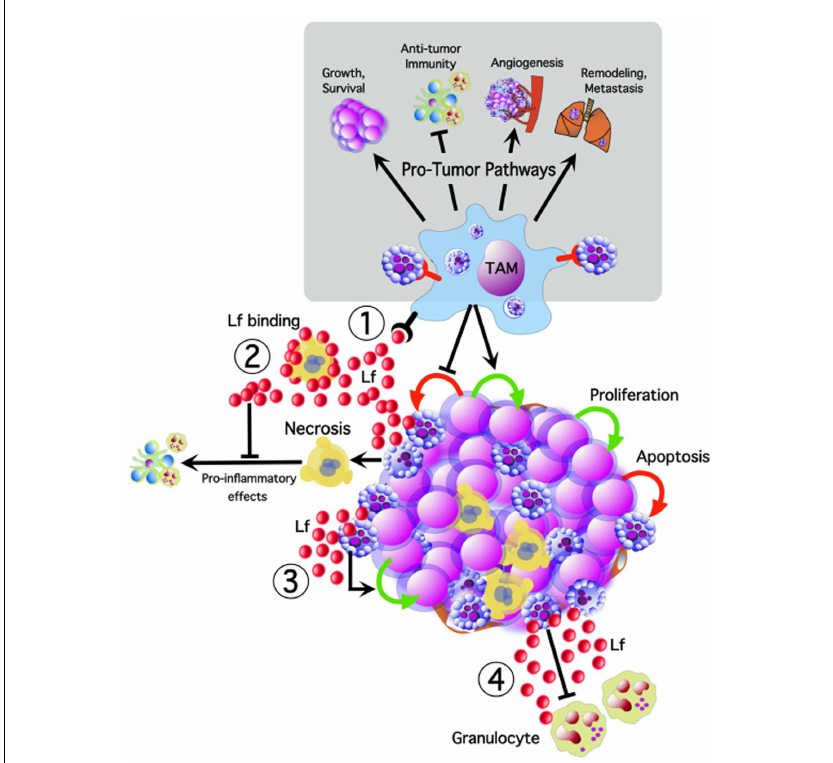
FIGURE 1 |Tumor cell apoptosis potentially activates multiple oncogenic pathways, promoting tumor cell growth and survival, angiogenesis, remodeling, and metastasis, while inhibiting anti-tumor immune responses .We propose thatTAM interacting with apoptotic tumor cells are central to many of these pathways. Apoptotic cells release lactoferrin (Lf) which could promote tumor growth and progression by: (1)TAM activation, (2) modulating the inflammatory effects of necrosis, (3) acting as a direct trophic factor, and (4) functioning as a “keep-out” signal to anti-tumor